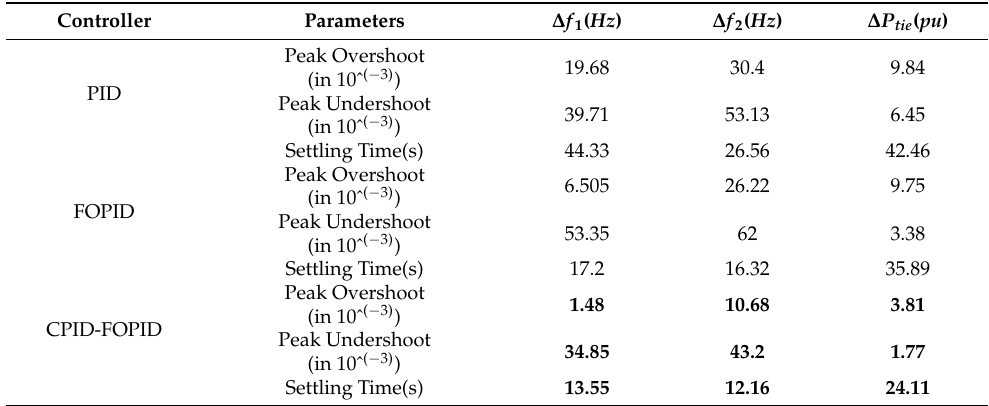
Figure 4. Dynamic responses of different controllers: ( a ) ∆ f 1 ; ( b ) ∆ f 2 ; ( c ) ∆ P tie ; ( d ) V t1 ; ( e ) V t2 . Table 5. Numerical values of T s ( s ), M P , and U P for